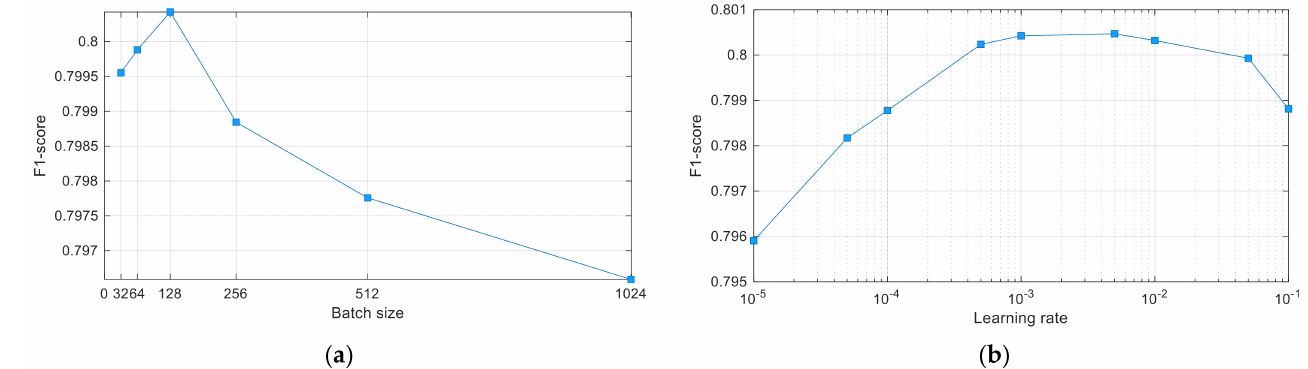
Figure 6. DenseNet-3 performance dependency on batch size ( a ) and learning rate ( b